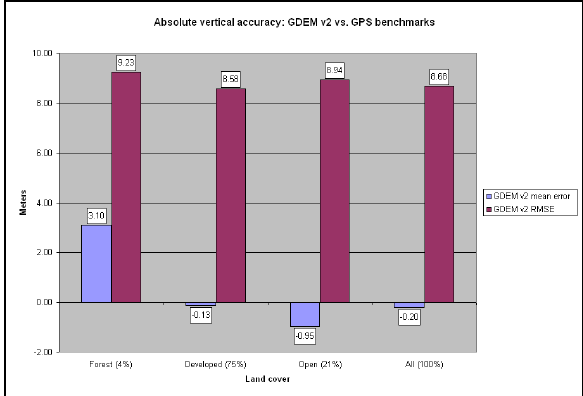
Figure 4. GDEM v2 mean error and RMSE by aggregated land cover